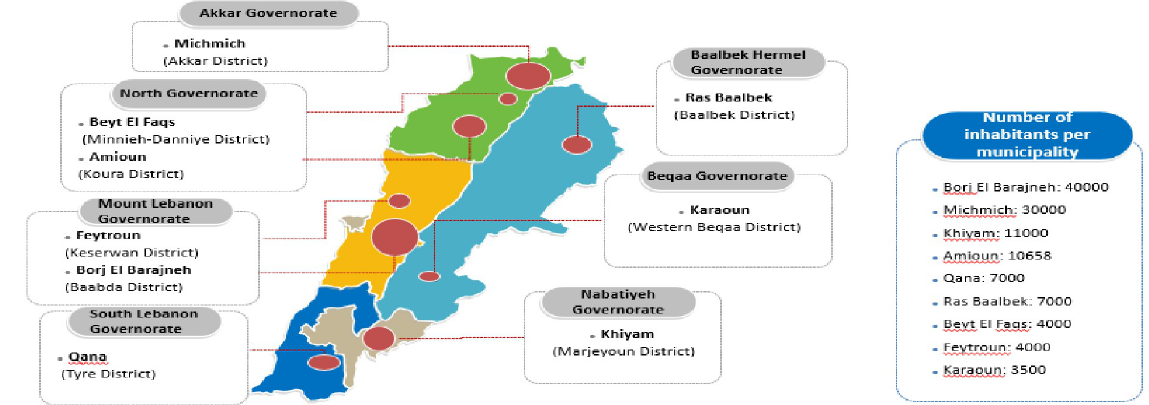
Fig 1. Distribution of selected municipalities per governorates and population density. Reprinted from [www.yourfreetemlates.com] under a CC BY-ND 4.0, with permission from the available website, original copyright [2017].